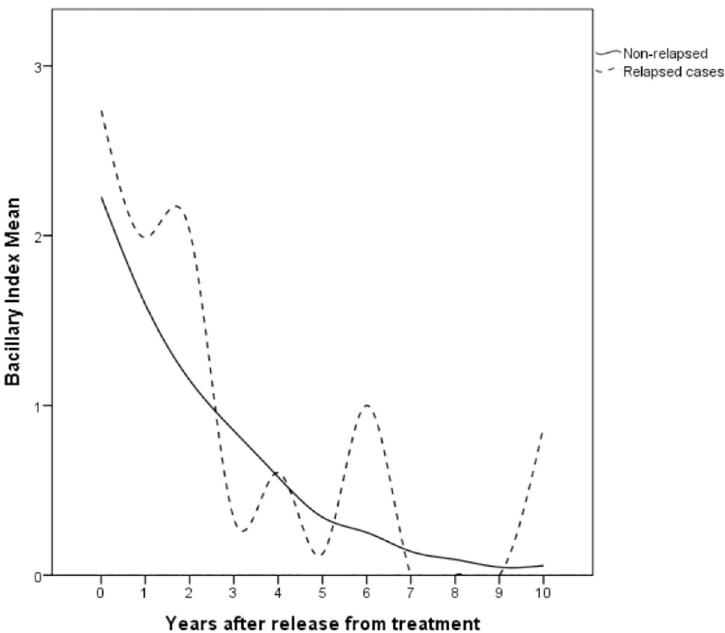
Fig 2. Spline curve of the annual bacillary index (BI) mean values in 12-dose MB-MDT Hansen disease patients. Progressive decrease of the BI obtained from slit-skin smear samples of non-relapse cases during the first years after release from treatment (full line). Observe that positive BI values remain long after release from treatment. Relapse cases (dotted line), however, show greater variability, possibly due to the small number, and display BI increases before relapse.